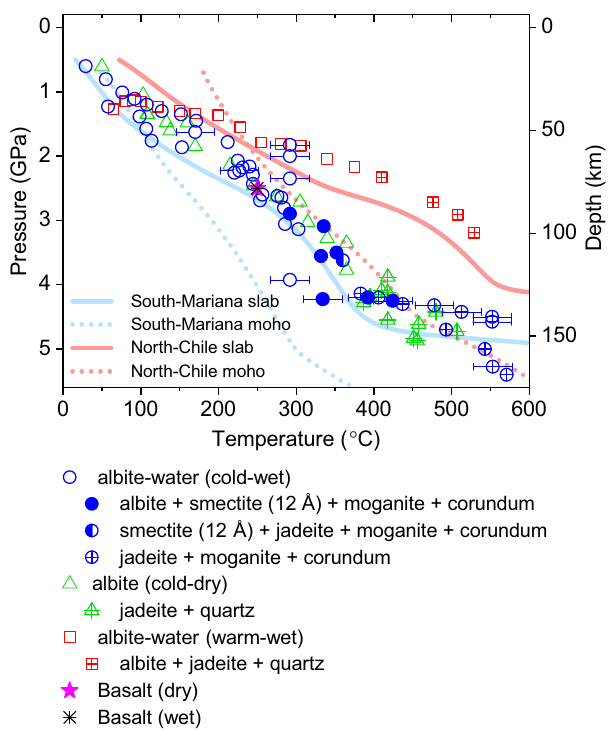
Fig. 1 Stability of albite along three different PT conditions. Thermal gradients of the Mariana (cold) and the North Chile (warm) slabs are shown in blue and red lines, respectively, following the W1300 model by Syracuse et al. 20 . Dotted lines are geotherms for 7 km beneath the respective slab surface. Horizontal error bars show the uncertainties in